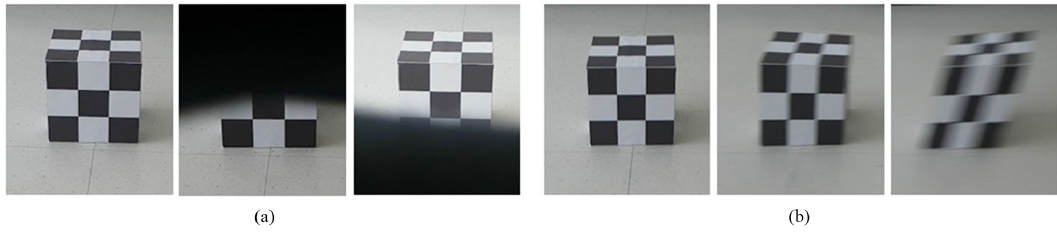
Figure 2. Common reasons for match-moving errors in traditional methods. ( a ) occlusion and ( b ) motion-blur cause problems in feature